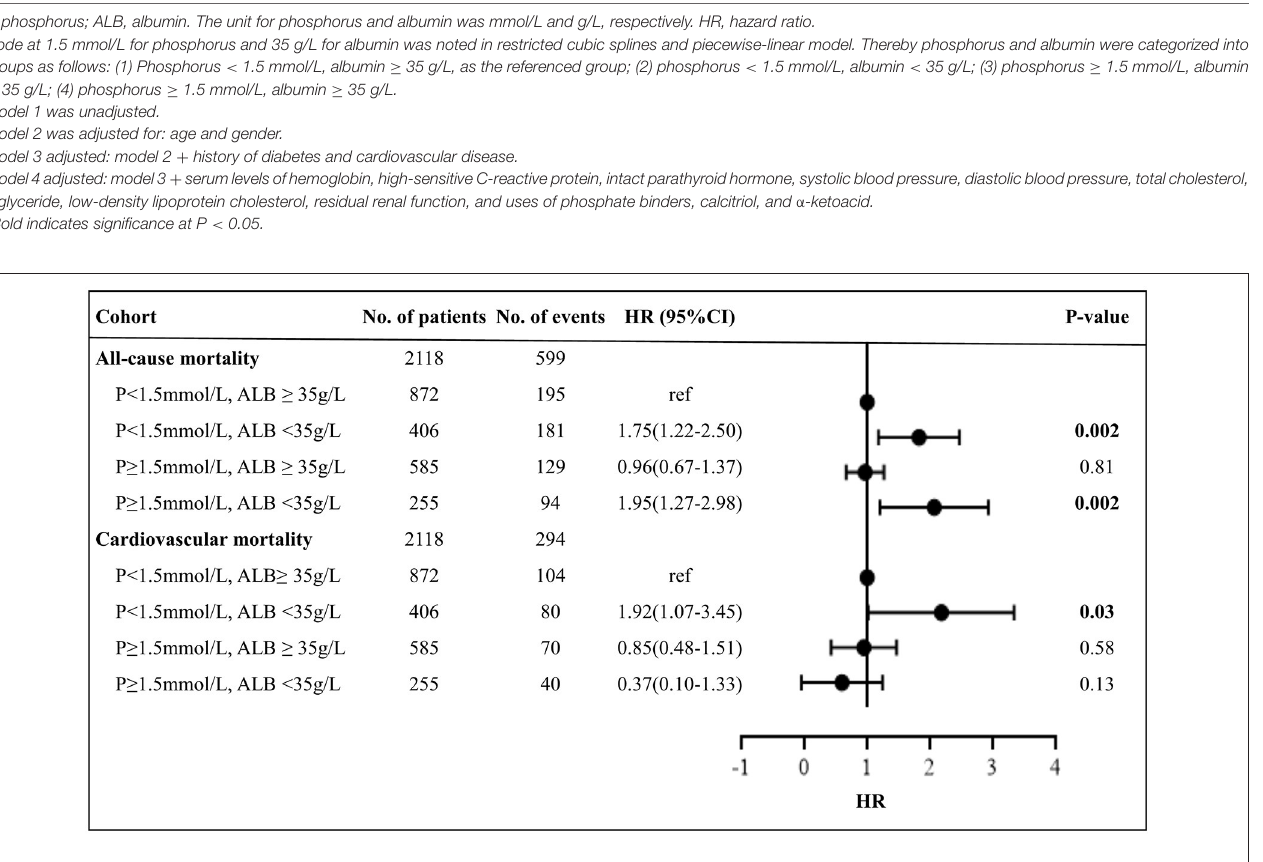
FIGURE 4 | Forest plot of mortality outcomes by subgroups. P, phosphorus; ALB, albumin; HR, hazard ratio. Bold indicates significance at p < 0.05. Cox regression results was from model 4 which was adjusted by age, gender, and history of diabetes and cardiovascular disease, serum levels of hemoglobin, high-sensitive C-reactive protein, intact parathyroid hormone, systolic blood pressure, diastolic blood pressure, total cholesterol, triglyceride, low-density lipoprotein cholesterol, residual renal function, and uses of phosphate binders, calcitriol, and α -ketoacid. HR > 1 indicates patients with phosphorus < 1.5 mmol/L and albumin ≥ 35 g/L